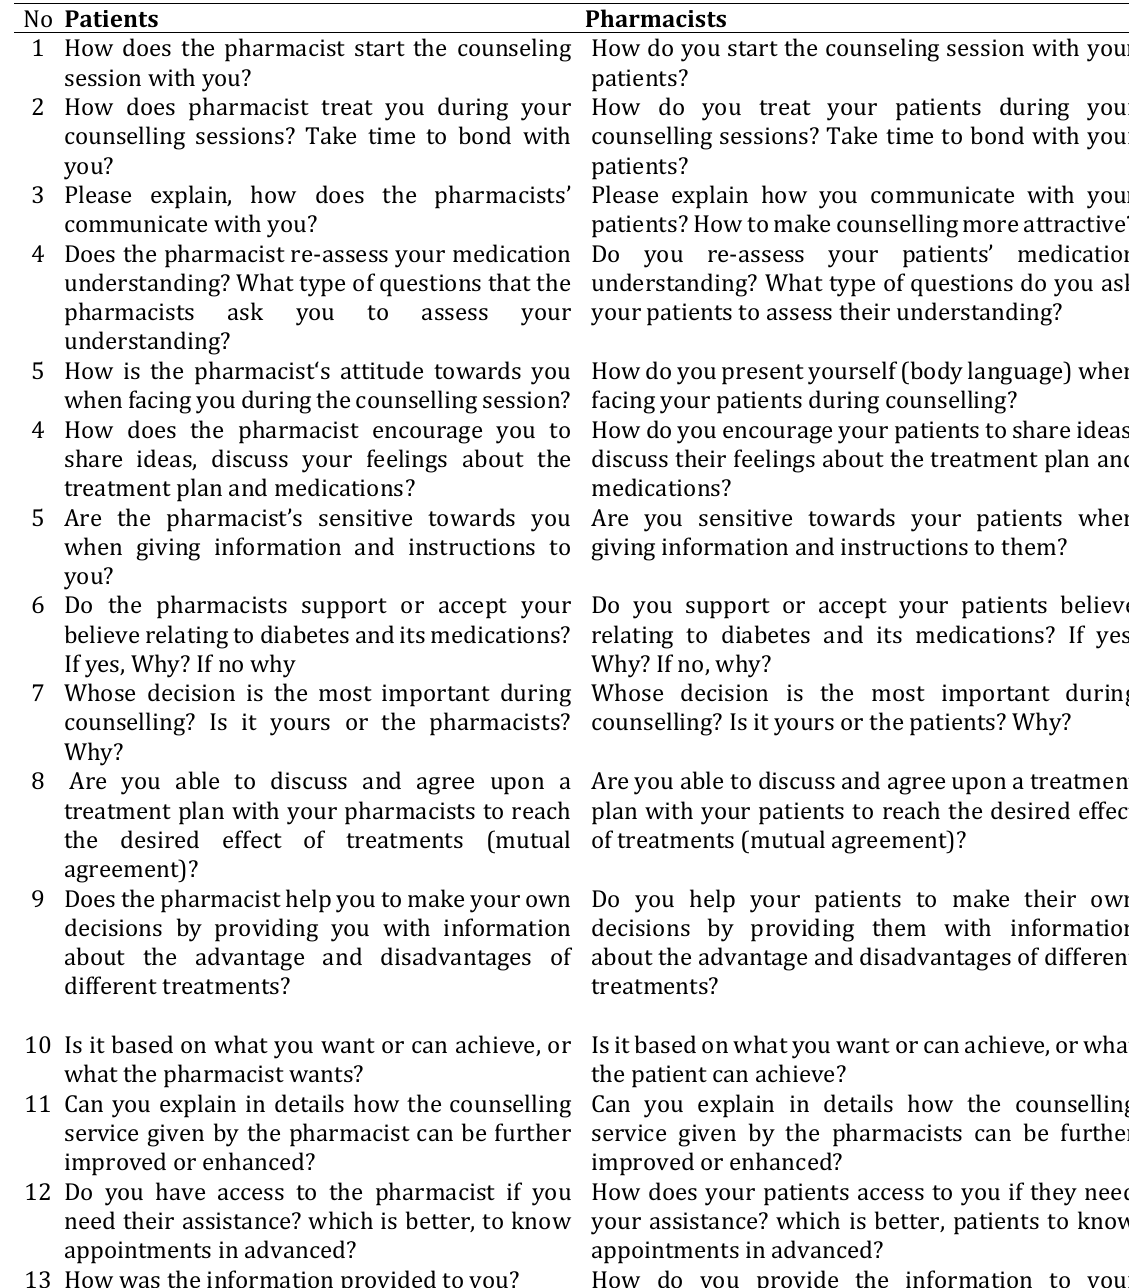
Table I. Interview guide for patients and pharmacists No